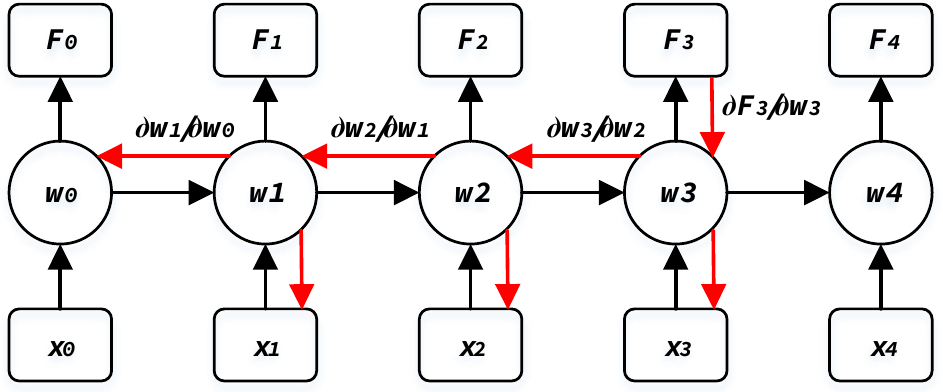
Figure 2. Schematic diagram of the error back propagation method for a recurrent neural network